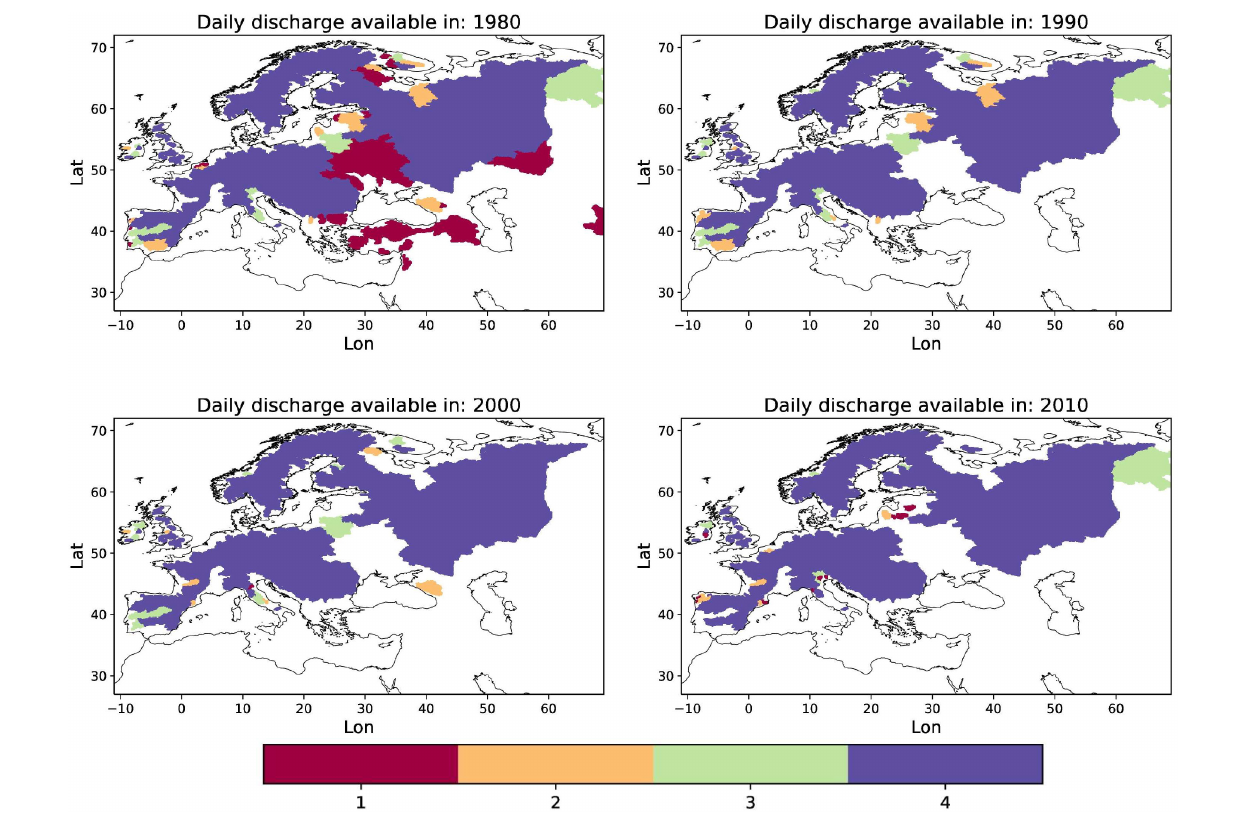
FIGURE 13 | Catchments with daily discharge observations available at a downstream station for more than 90% of days in the years 1980, 1990, 2000, and 2010. Colors indicate the number of years within these 4 years, when discharge data are available.